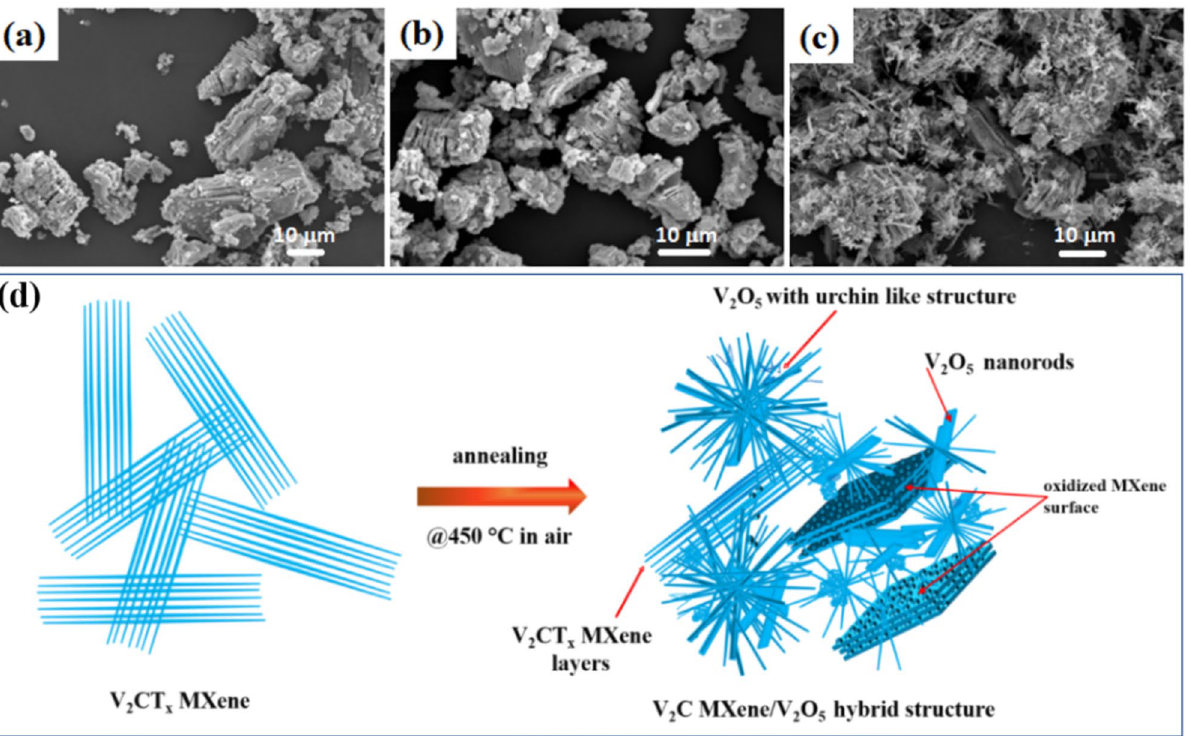
Figure 4. SEM images of V 2 CT x MXene calcined at different temperatures: 300 °C ( a ), 350 °C ( b ), 450 °C ( c ), and ( d ) Schematic diagram of the formation of the V 2 C MXene-derived, urchin-like V 2 O 5 structure annealed at 450 °C in air.